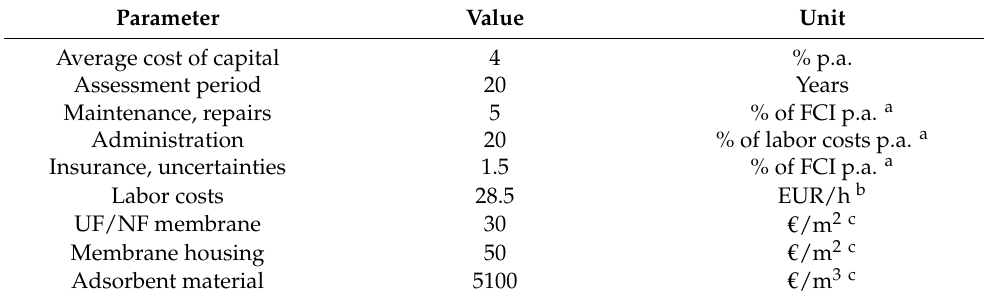
Table 2. Main assumptions for costing.